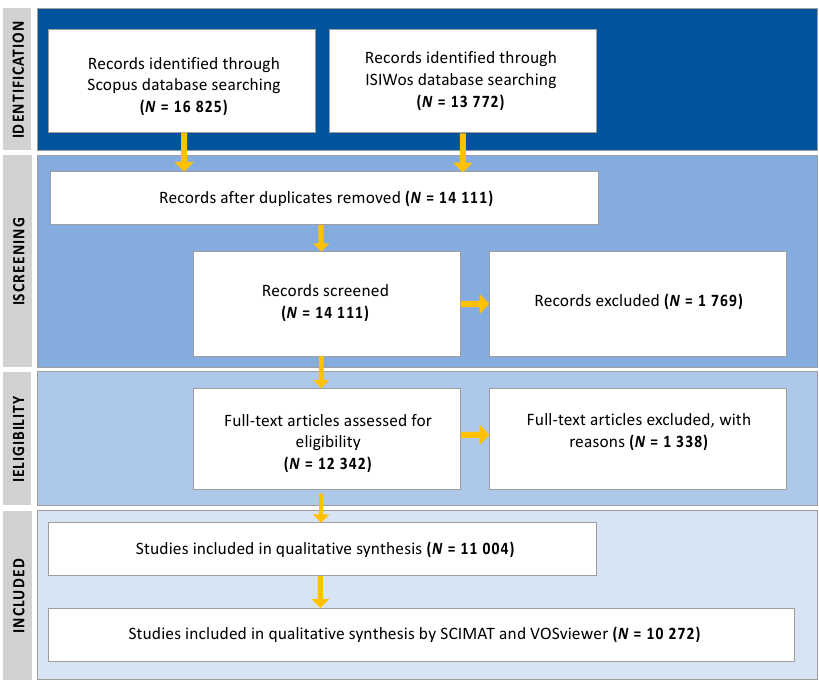
Figure 2. PRISMA flowchart.